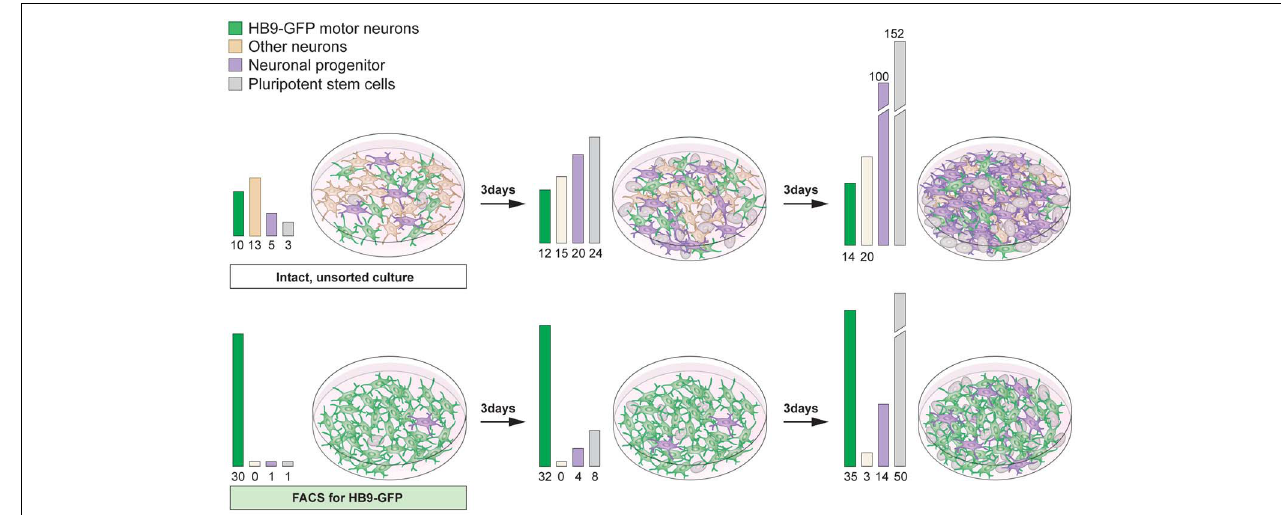
FIGURE 7 | Proliferative cells can become the main component of differentiated stem cell cultures with time. Differentiation of pluripotent stem cells using RA and Shh results in the generation of motor neurons (15–30%) and interneurons, particularly V0 and V1. The culture will also contain neuronal progenitors and pluripotent stem cells ( top panel ). If the intact culture is maintained, after differentiation, proliferating cells will soon